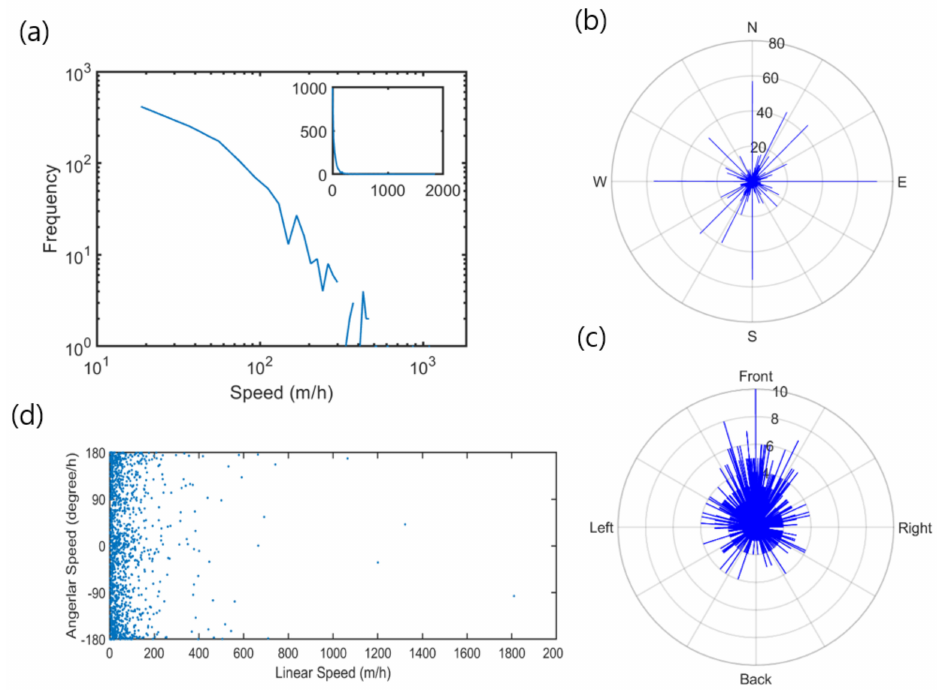
Figure 4. Linear and rotating movement parameters of nutria individuals observed in the Macdo wetland during the survey period; ( a ) frequencies of linear speed in logarithm (inset showing frequencies of linear speed in full scale); ( b ) orientation; ( c ) angular speed; and ( d ) the relation between linear and angular